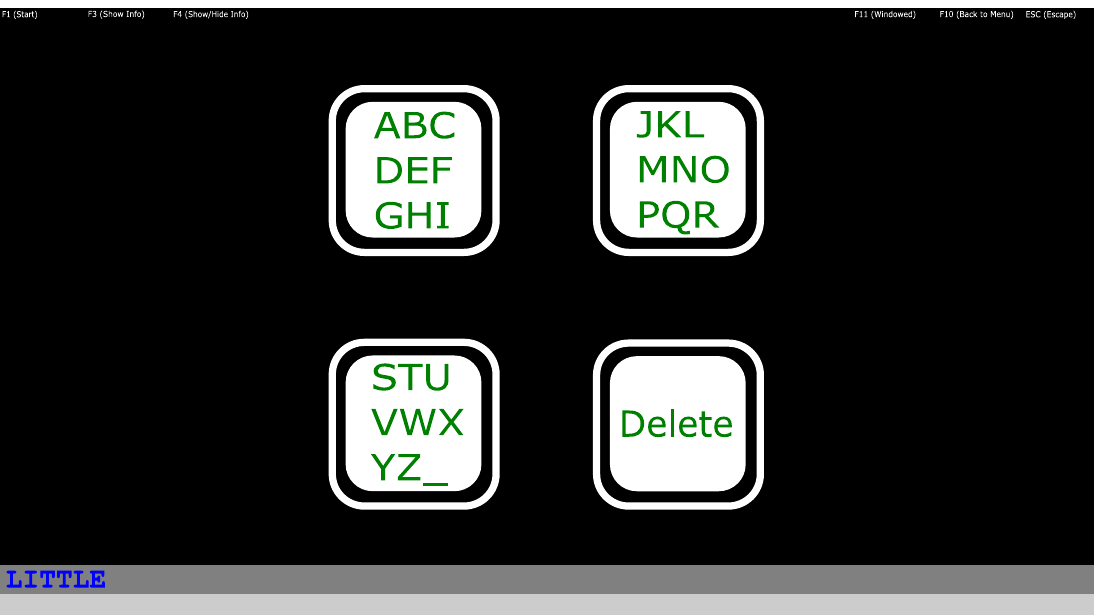
Figure 2. The 4-target interface. The word “LITTLE” notes the target word to be spelled by the subject. The text written by the users was shown at the bottom of the screen, in the line below the target